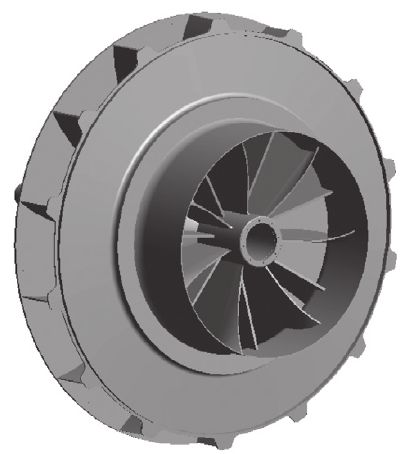
Figure 21 - Original rotor